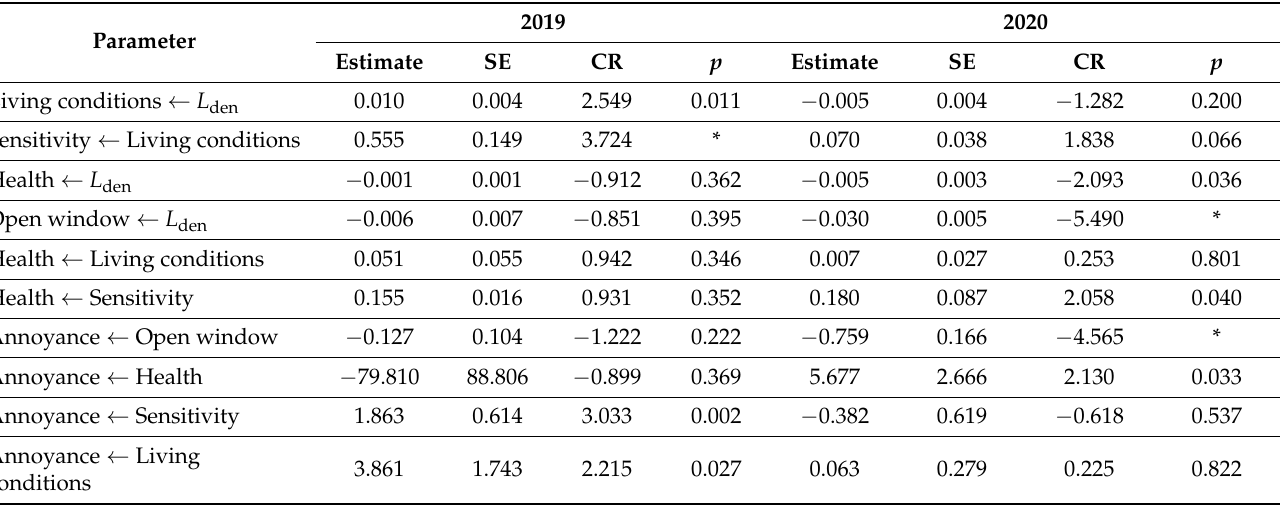
Figure 3. The structural equation model estimated the noise annoyance with the opening of the bedroom window variable in the 2019 and 2020 surveys using chi-square, GFI, CFI, and RMSEA statistics: chi-square = 224.970, p < 0.01, df = 74, GFI = 0.941, CFI = 0.856, and RMSEA = 0.057. Statistically significant paths and standardized regression weights are annotated with ( p < 0.05). The non-significant paths are represented by dashed lines. The explained variances are annotated for each variable. Table 11. Parameter estimates of the structural equation model for noise annoyance with opening of the bedroom window during the dry